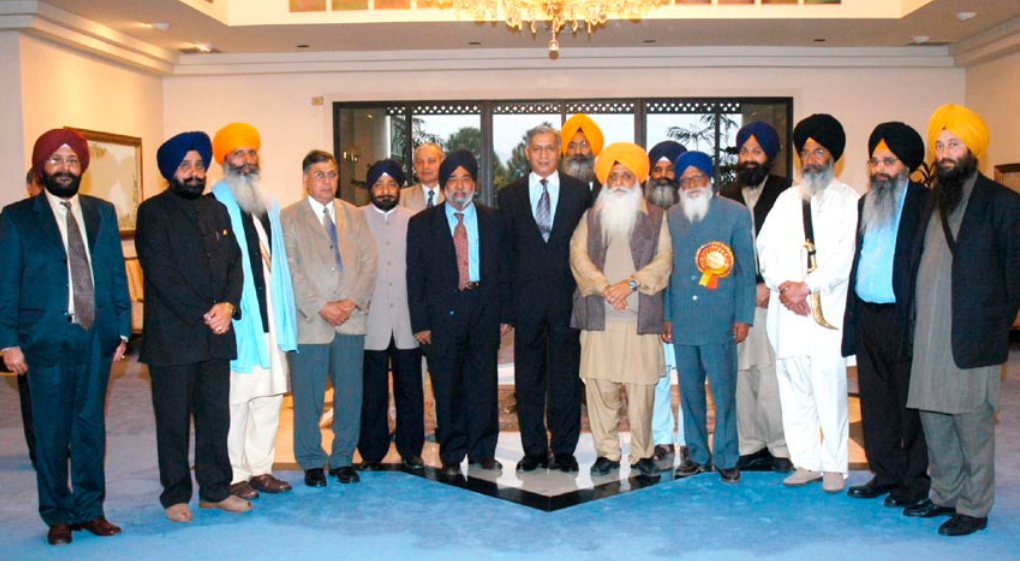
Figure 1. A Sikh delegation with Prime Minister Shaukat Aziz at the prime minister’s house on 29 November 2004. Charan Singh Sangatpura, the third from the left in the orange dastar (turban), has led several delegations since the 1980s.